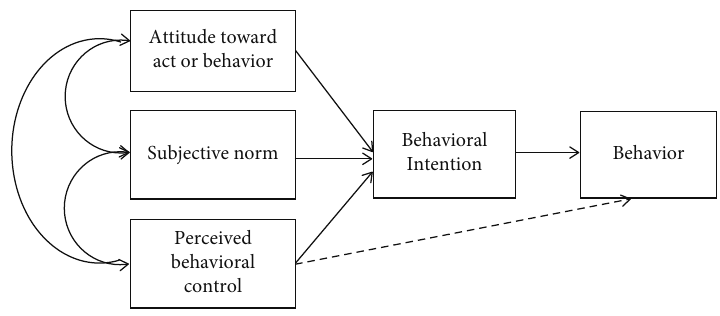
Figure 7: Theory of planned behavior